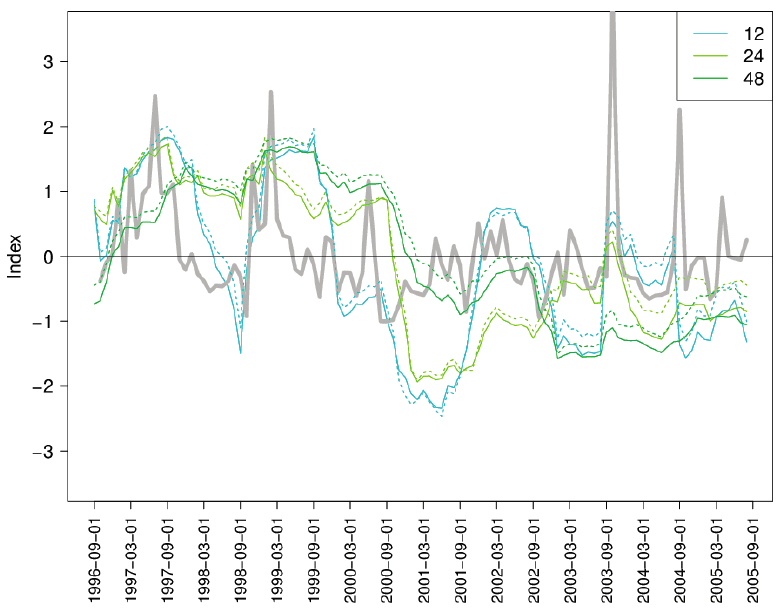
Figure 10. The SPEI and SPI for the 12, 24, and 48-month time scale and the standardized runoff for the SR (grey) over 1996–2005.